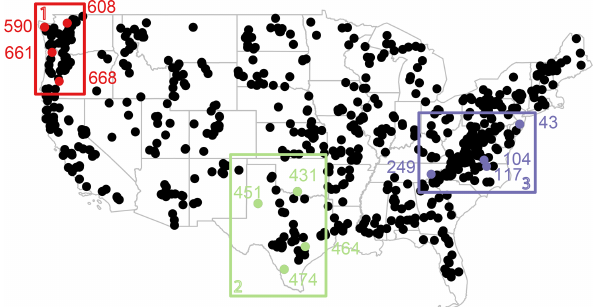
Figure 1. Location of 671 stations in the dataset and of four catch- ments chosen per example region: (1) Pacific Northwest (red; 590, 608, 661, and 668), (2) Texas (light green; 431, 451, 464, and 474), and (3) Mid-Atlantic (purple; 43, 104, 117, and